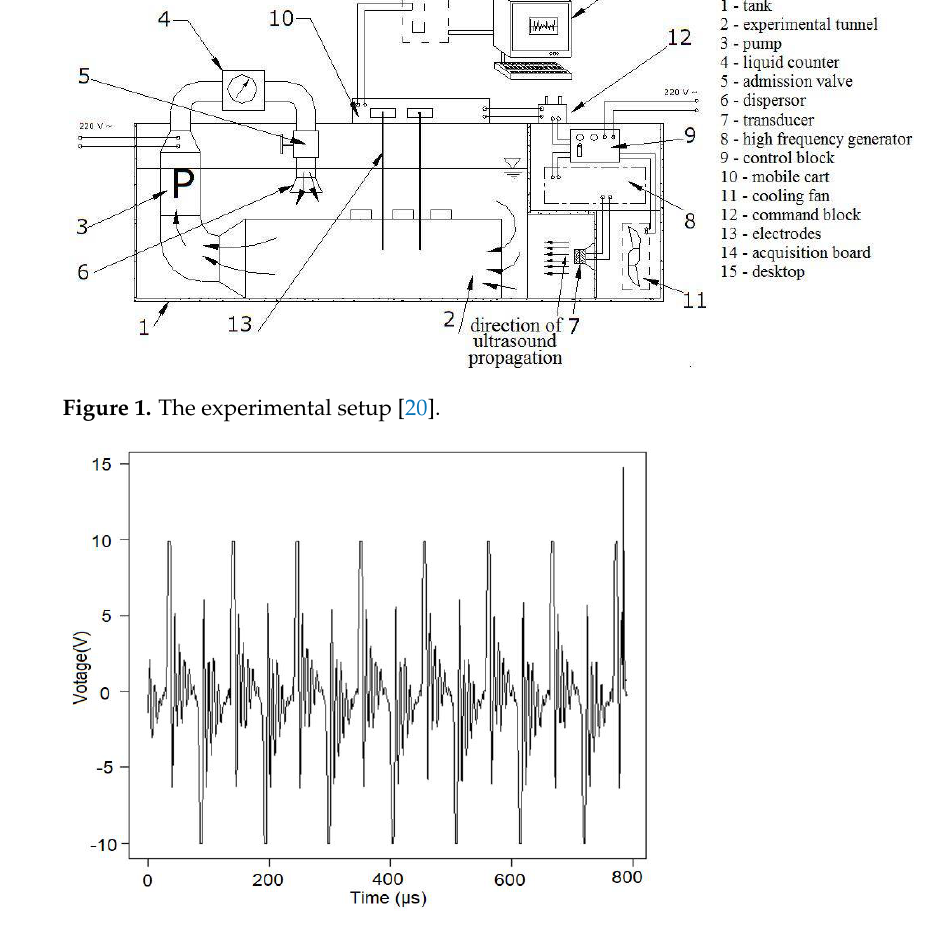
Figure 2. Voltage collected at 80 W in seawater (built using the R software).